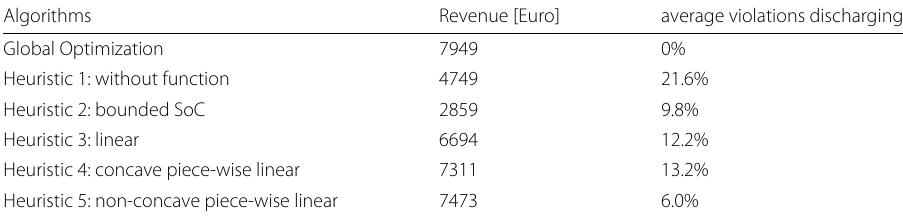
Table 2 Performance of solving the global optimization problem (1): The heuristic candidates with different f char / dischar models are compared to the optimal solution from solving the global optimization problem as a linear program